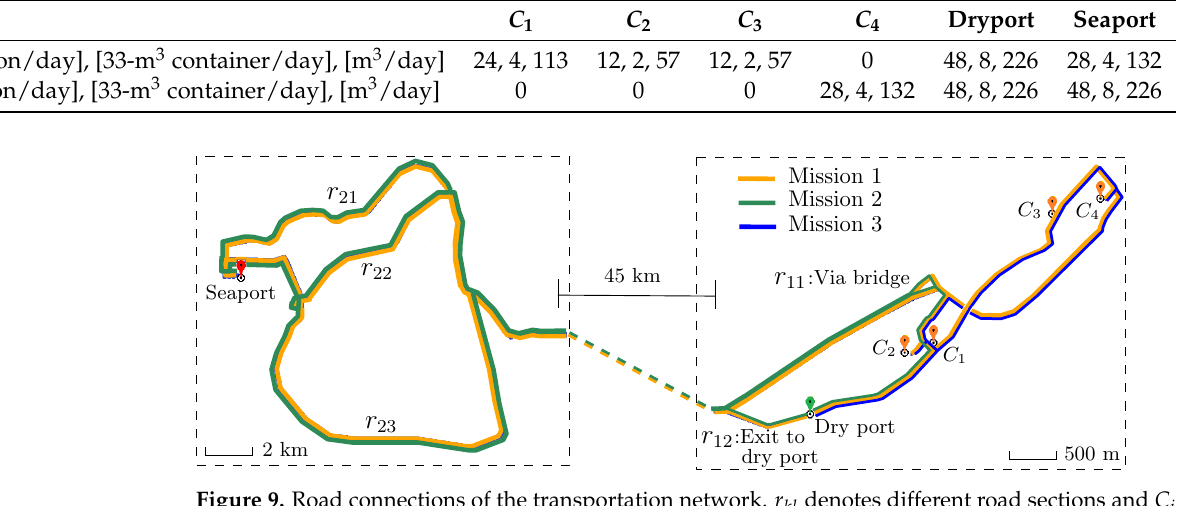
Figure 9. Road connections of the transportation network. r kl denotes different road sections and C i denotes the i th customer. Different road colors represent different transport